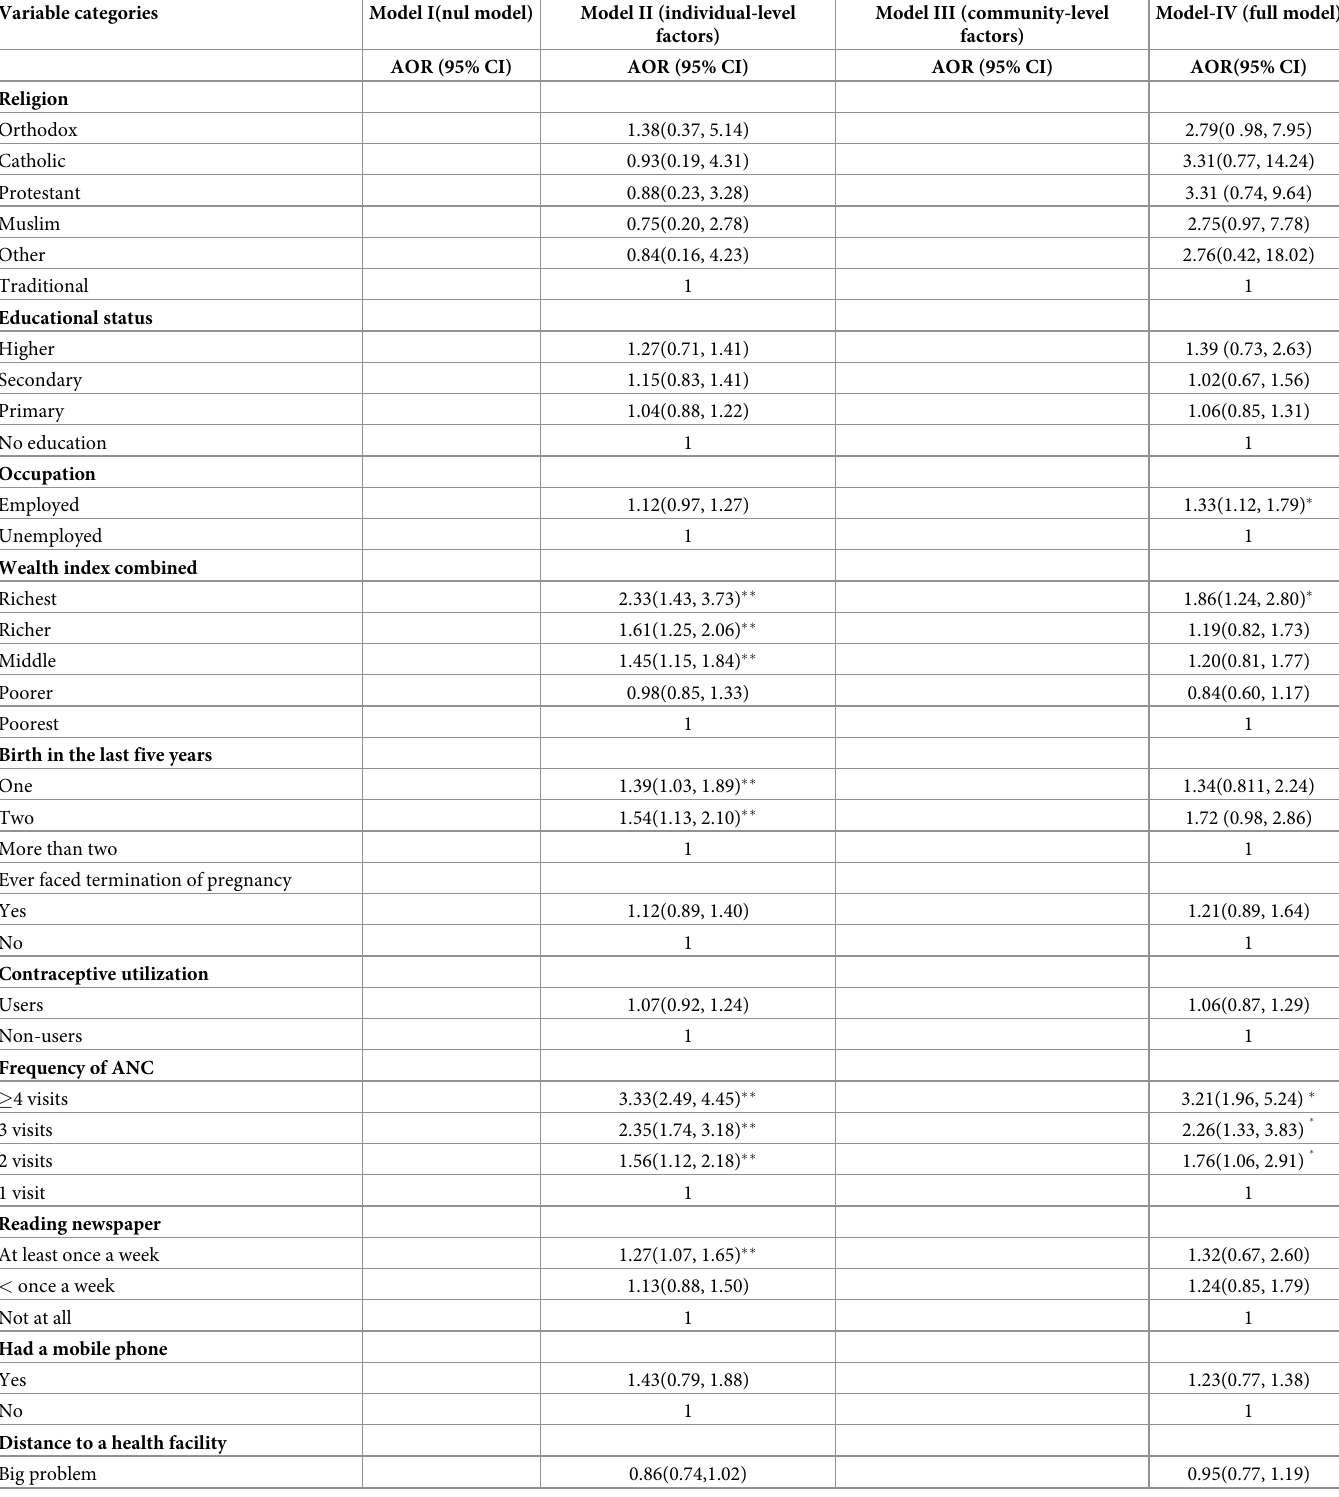
Table 5. Results of a multilevel mixed-effect multivariable logistic regression analysis to identify the factors affecting the uptake of BPCR messages among pregnant women in Ethiopia,